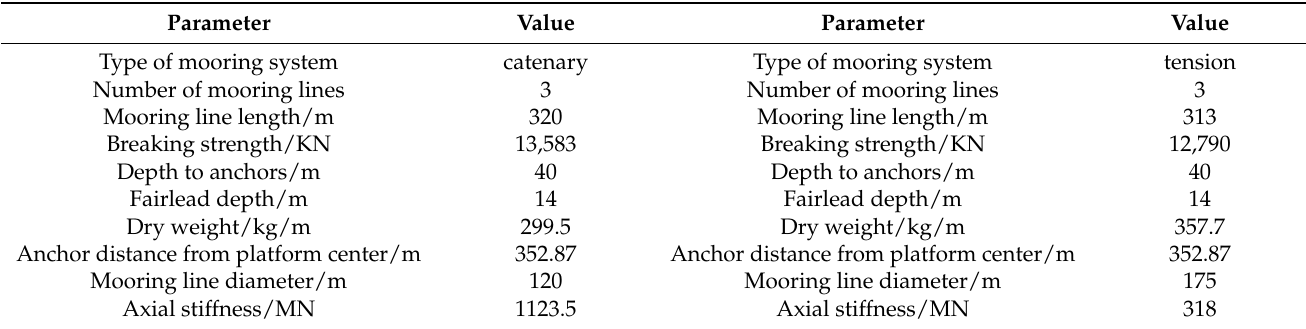
Table 3. Mooring system parameters.